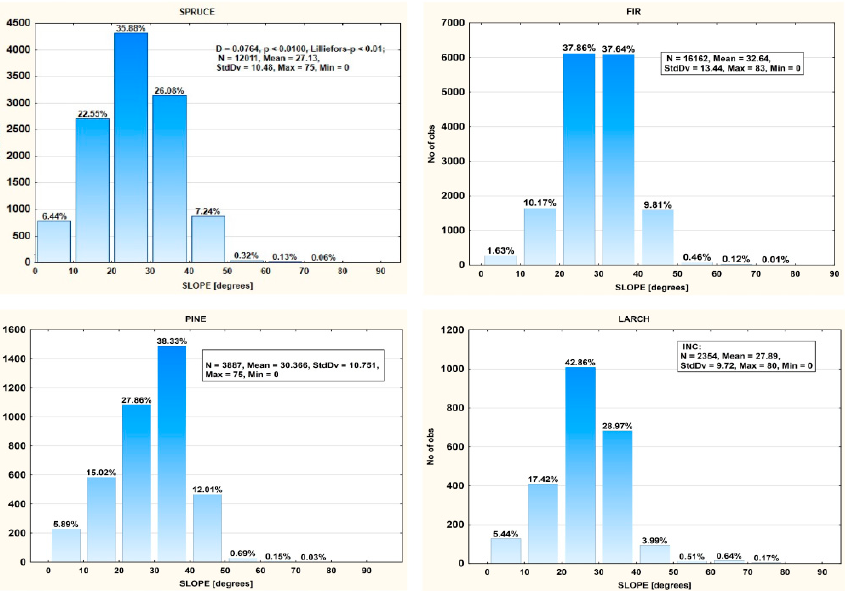
Figure 3. Distribution of stand elements based on field slope for resinous species located in Southern Carpathians.